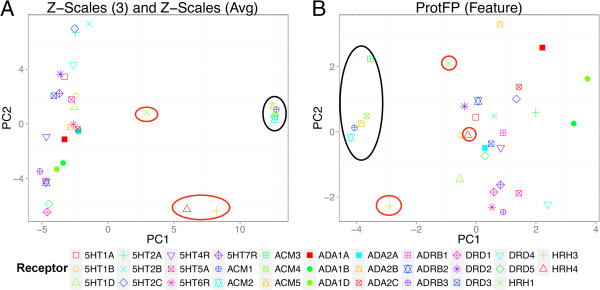
PCA plot of GPCR data set target space. (A) Shown are the best performing descriptor (Z-Scales (3) and Z-Scales (Avg)), and (B) the worst performing descriptor (ProtFP (Feature)). The (A) panel shows are more explicit clustering compared to ProtFP (Feature) in (B). The red circles indicate the histamine receptors and the black circles the muscarinic acetylcholine receptors. The lower performance of the histamine receptor family can be rationalized in both cases, as no clear clustering is apparent for this family. Conversely, both plots demonstrate clustering for the ACM receptors, which might explain the good performance.